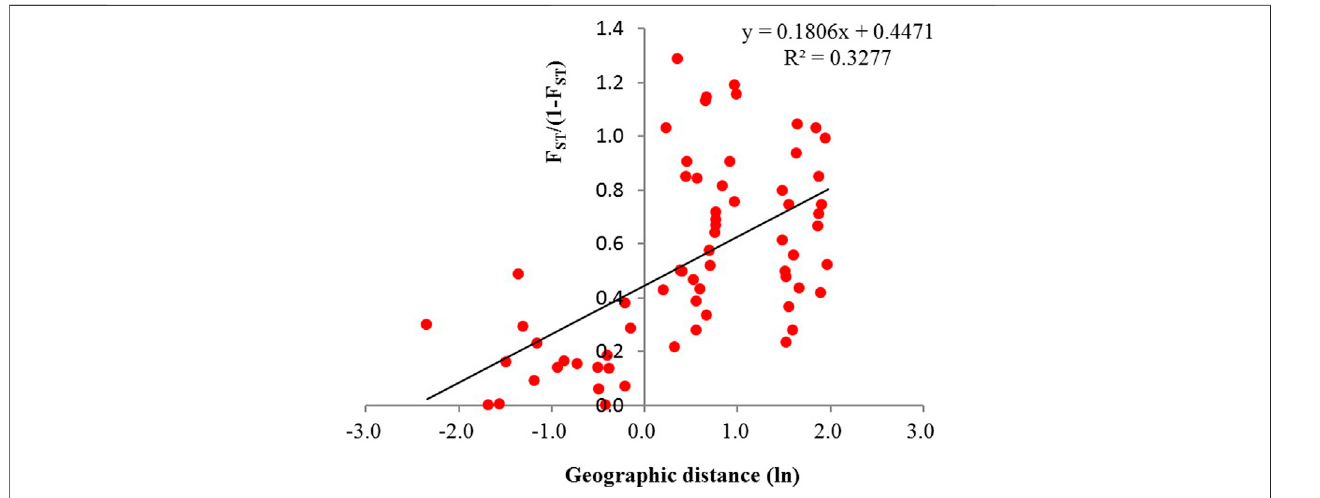
FIGURE9| Relationshipbetweenpairwise F ST /(1 − F ST )andthegeographicdistance(ln)amongthe12populationsof Primulinadanxiaensis ( r (cid:1) 0.572, p < 0.001).